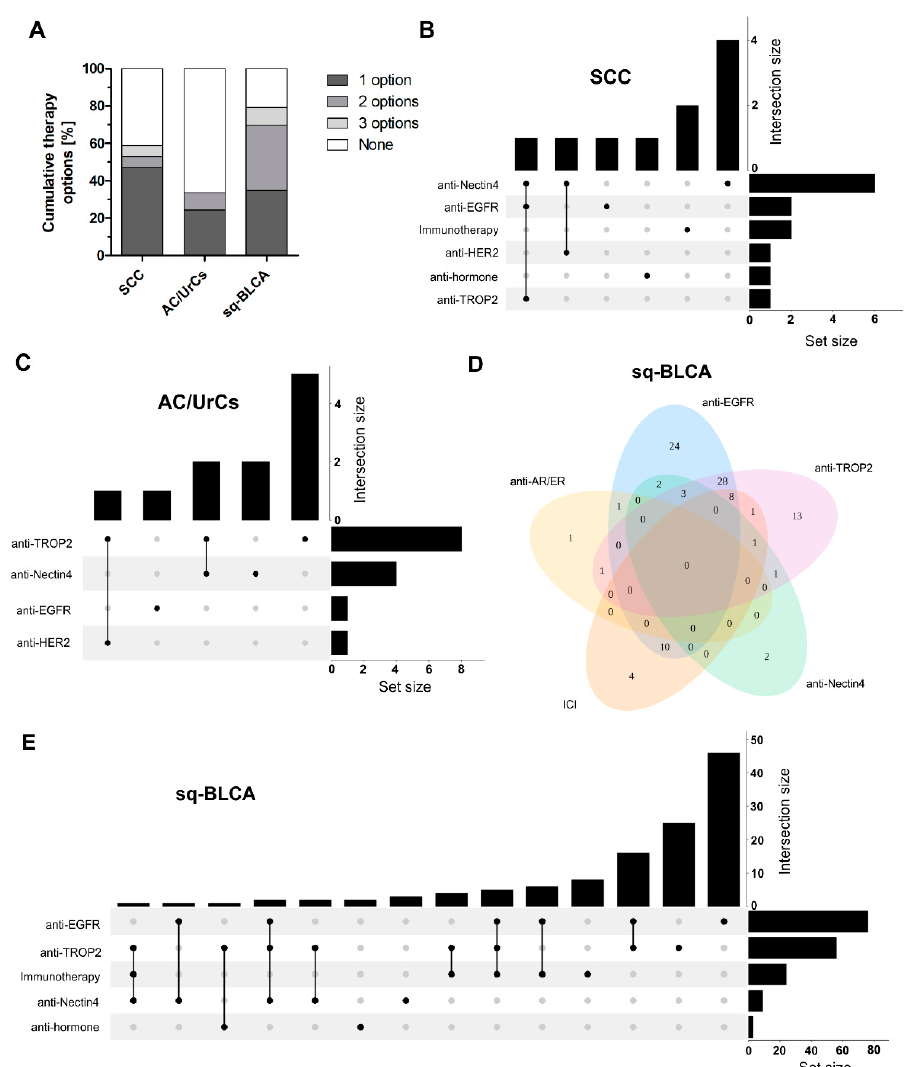
Figure 6. Overlapped and cumulative sets of dysregulated targets potentially relevant for therapeutic intervention in different nonurothelial bladder cancer subtypes. ( A ) Fractions of patients potentially treatable by one, two, or three different drugs according to the expression of analyzed predictive markers. ( B , C ) UpSet plots show frequency of different combinations of overlapped predictive markers (intersection size) compared to the overall number of strong expressed markers (set size) in SCC ( B ) and Ac/UrCs ( C ). ( D ) Venn diagram illustrates overlaps of predictive markers in sq- BLCA. ( E ) UpSet plots show frequency of different combinations of overlapped predictive markers (intersection size) compared to the overall number of strong expressed markers (set size) in sq- BLCA. Please note: Only samples with two or more analyzed targets were considered.